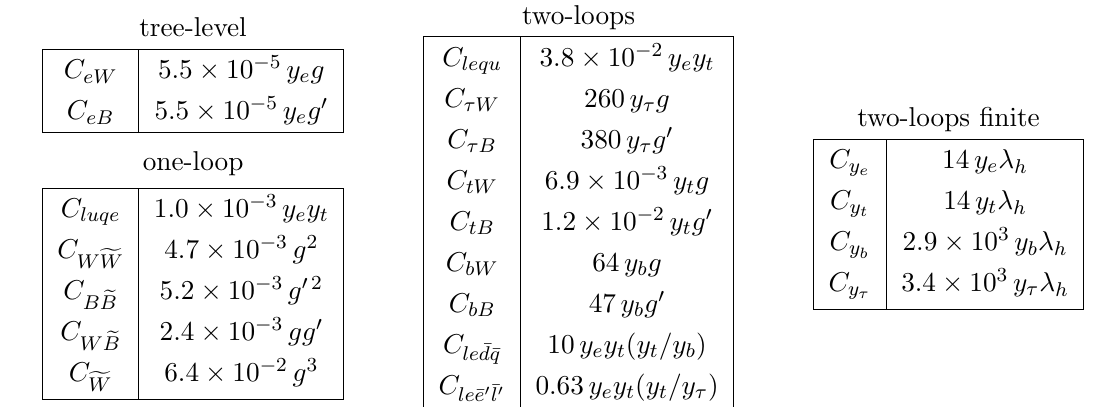
Table 4 . Bounds on the Wilson coe(cid:14)cients coming from eq. (1.1) taking (cid:3) = 10 TeV. For a better appreciation of the bound, we have extracted the Yukawa, gauge or Higgs coupling ( (cid:21) h = 0 : 1) that we naturally expect to carry these Wilson coe(cid:14)cients. For C extracted a factor ( y t =y b ) and ( y t =y (cid:28) ) respectively to re(cid:13)ect the fact that these coe(cid:14)cients can be potentially larger consistently with their natural sizes eq.